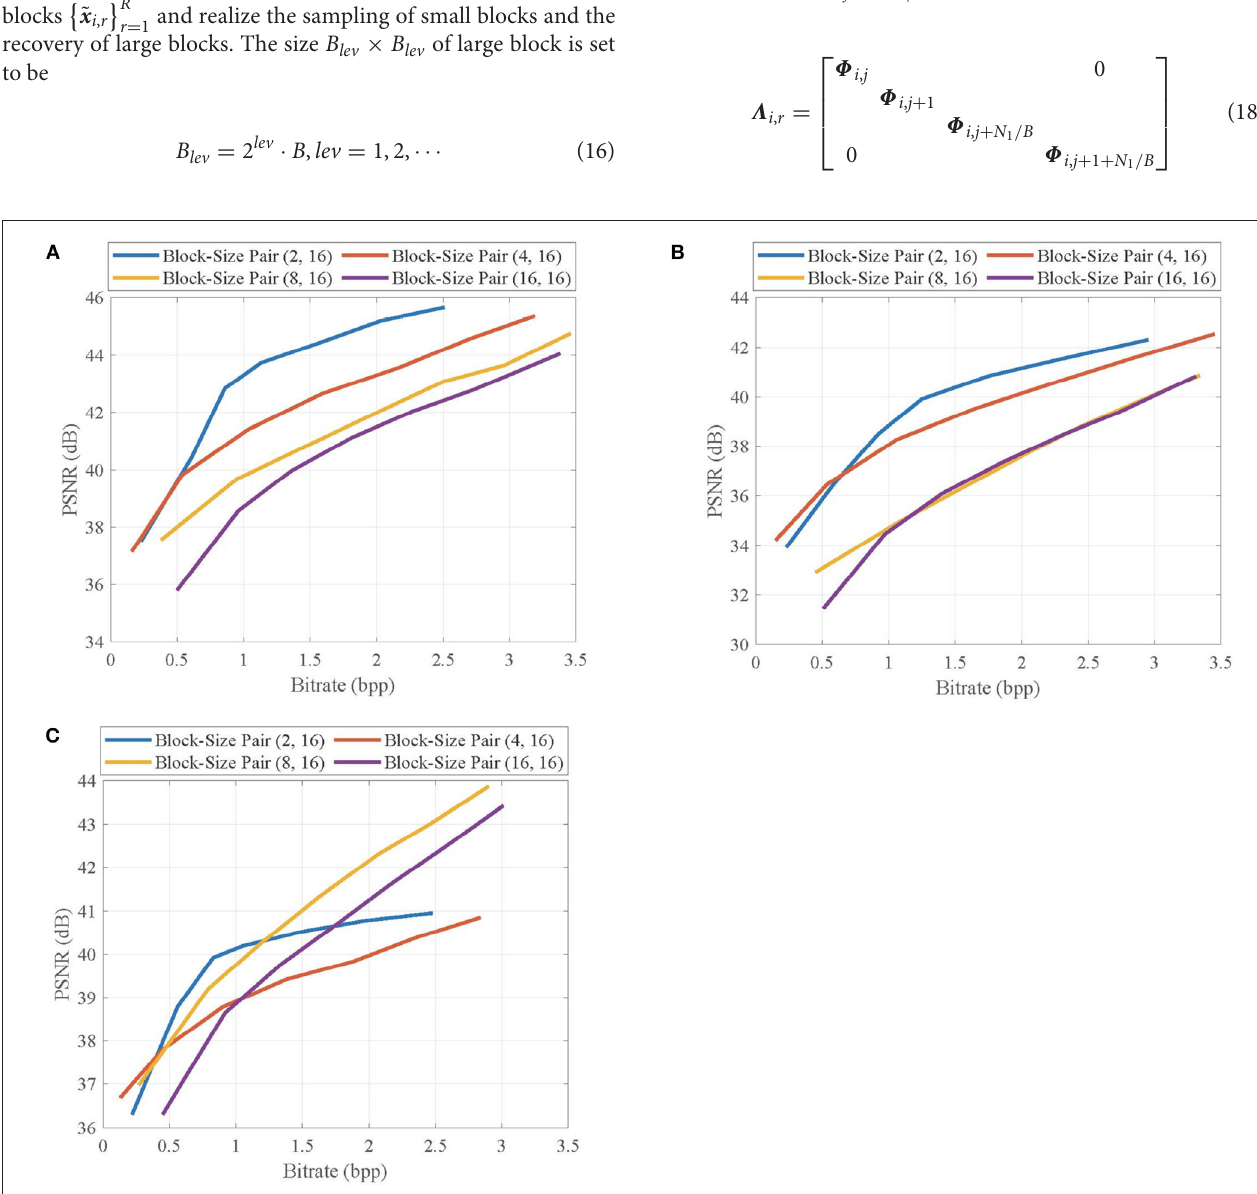
FIGURE 8 | Rate-distortion curves of the reconstructed non-key frames in (A) Foreman , (B) BlowingBubbles , and (C) ParkScene sequences at different block-size pairs.